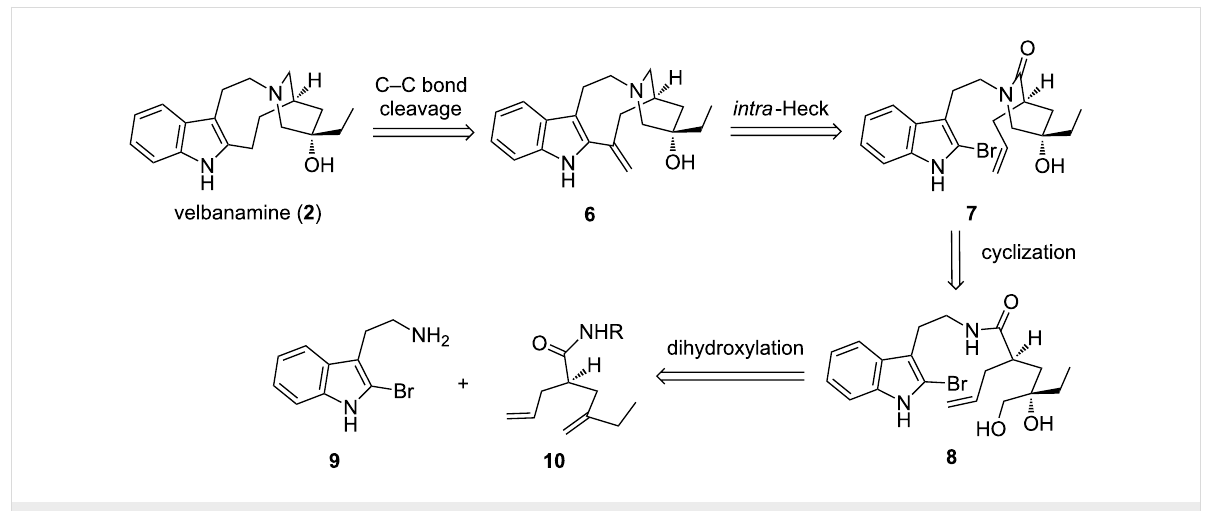
Scheme 2: Synthetic strategy for velbanamine based on chemoselective